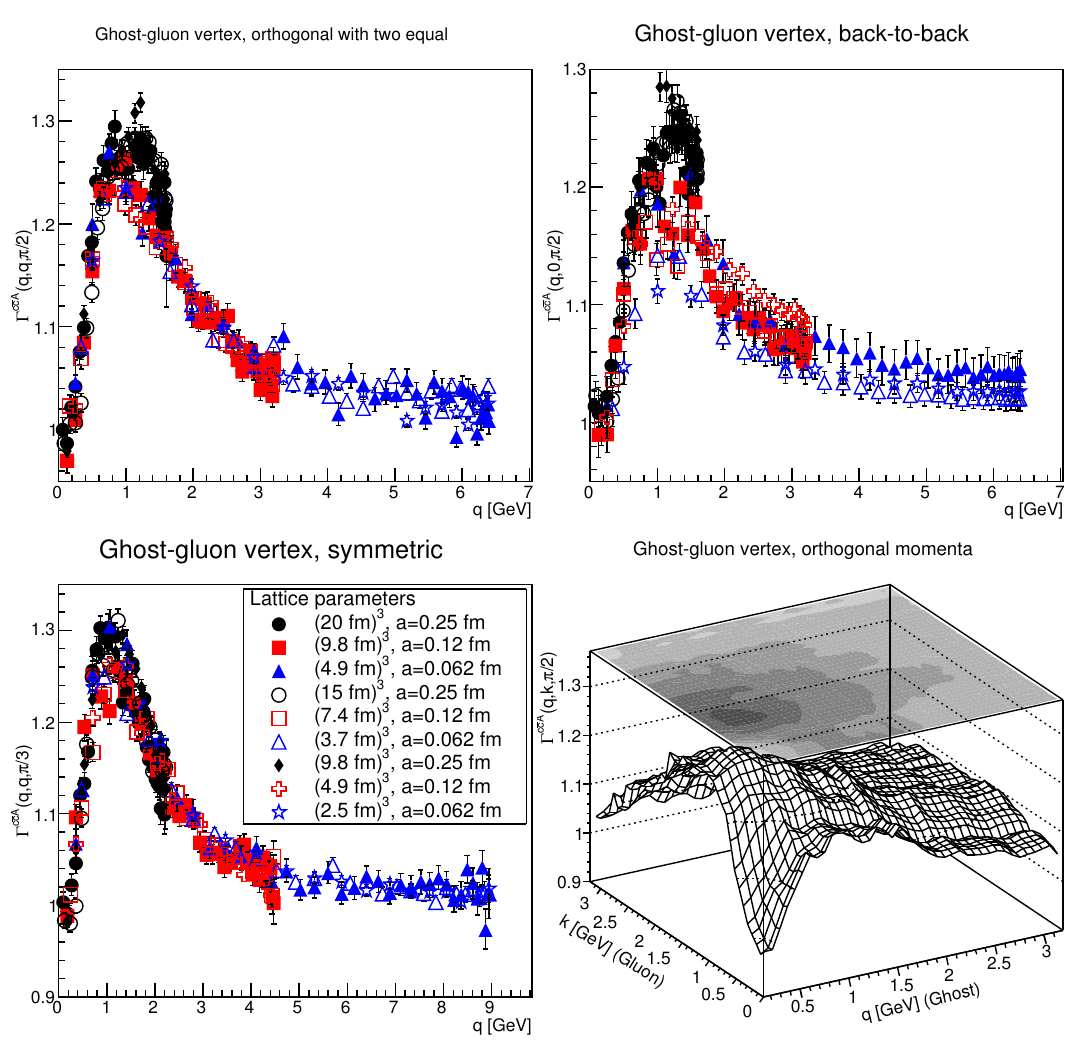
Figure 5: The ghost-gluon vertex in three dimensions. The top-left panel shows a cut along the diagonal of the lower-right plot. The latter shows the situation with the gluon momentum being orthogonal to the ghost momentum, with interpolation of the data points for the largest volume at the intermediate discretization. The top- right panel shows the back-to-back momentum configuration and the bottom-left panel the symmetric momentum